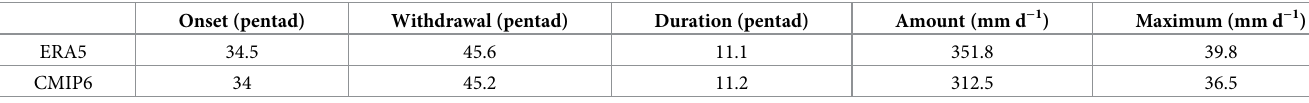
Table 2. The values for the characteristics of EASM. Onset (pentad)